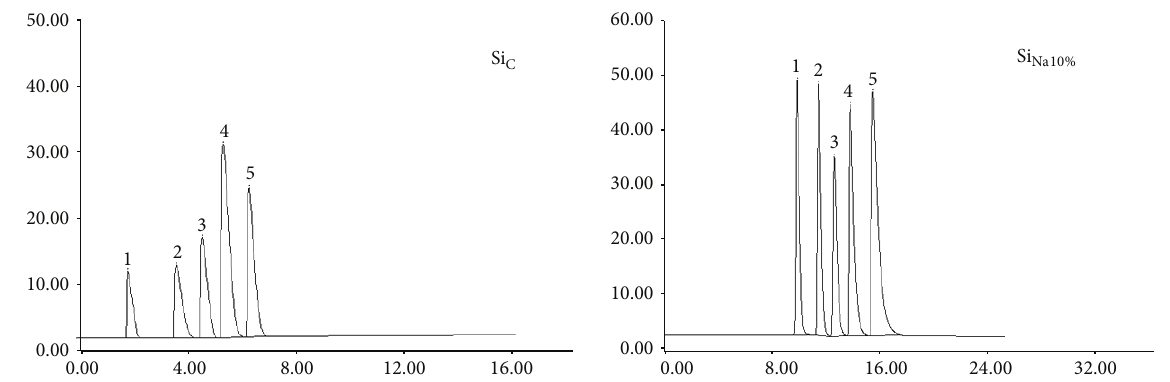
Figure 4: Gas chromatographic separation of aromatic hydrocarbons on modified silica gel, at optimum condition (80 ∘ C for 2min; 20 ∘ C/min to 220 ∘ C; final time 10min, 30mL/min). Table 4: Separation efficiency parameters of selected stationary phases using paraffins as probes. Columns